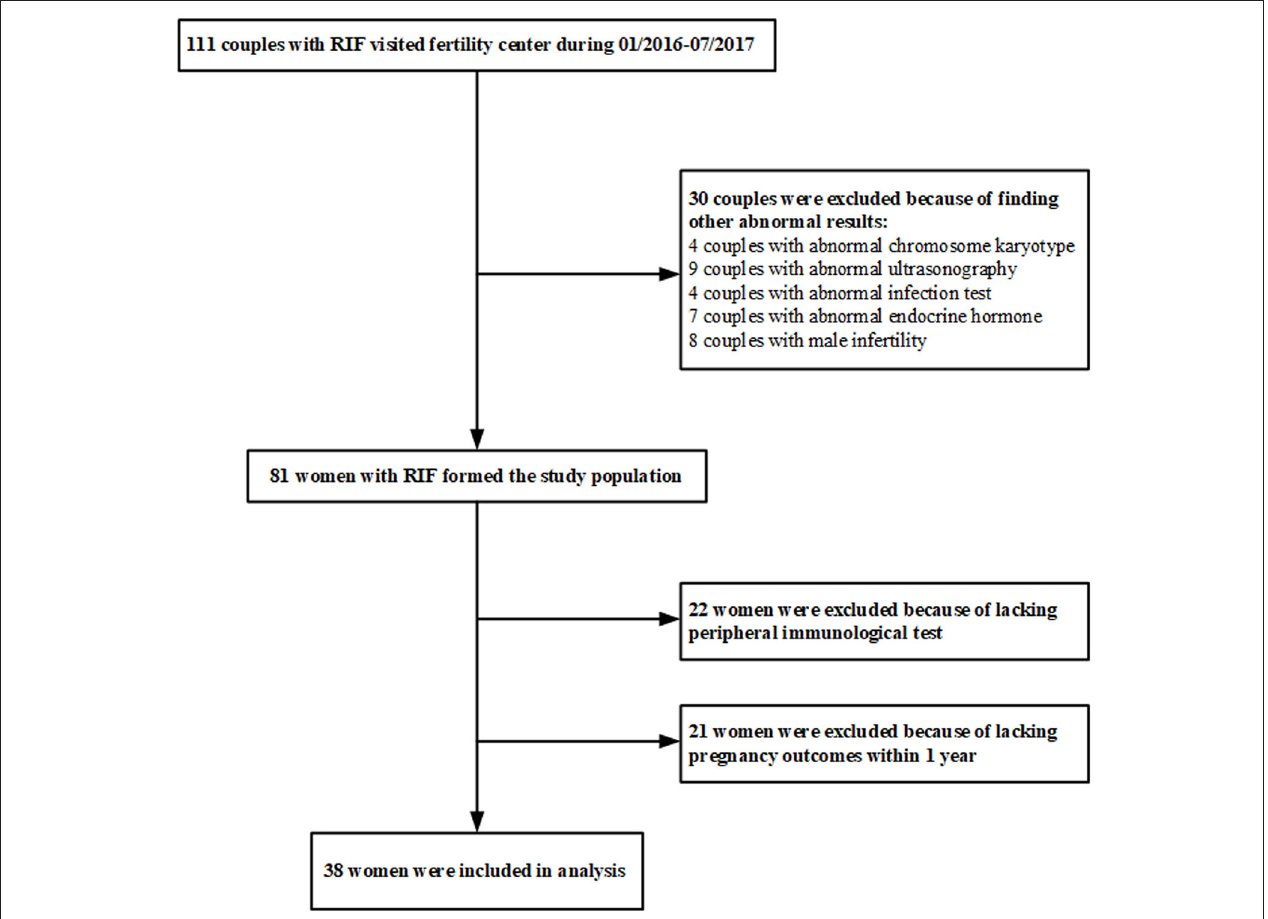
FIGURE 1 | Flowchart listing the inclusion and exclusion criteria to select patients in this